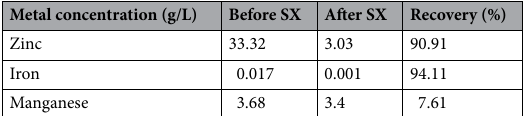
Table 7. 2 stages zinc solvent extraction.